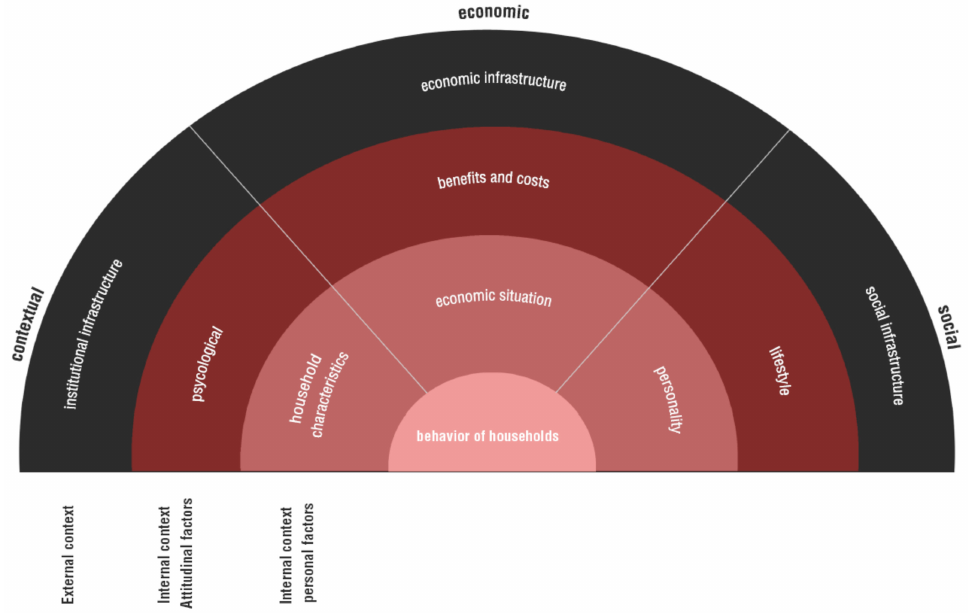
Figure 1. Conceptual framework to understand households’ energy e ffi ciency